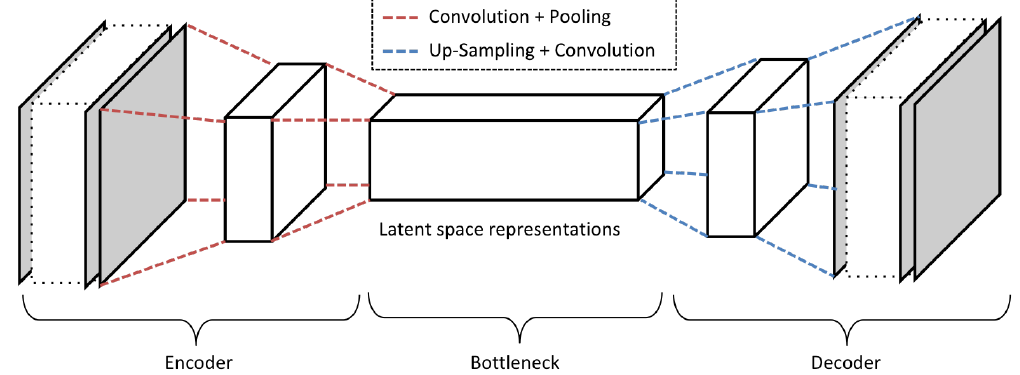
Figure 13. An example of a 3D auto-encoder with a couple of convolution layers followed by pooling layers at the encoder and a couple of up-sampling layers followed by convolutional layers at the decoder part, which learns the representations from an unlabelled set of data. In such an unsupervised learning strategy, the learning process takes place to encode the data into a set of representations, and the decoder evaluates how the representations are good enough to reconstruct the original data using the same